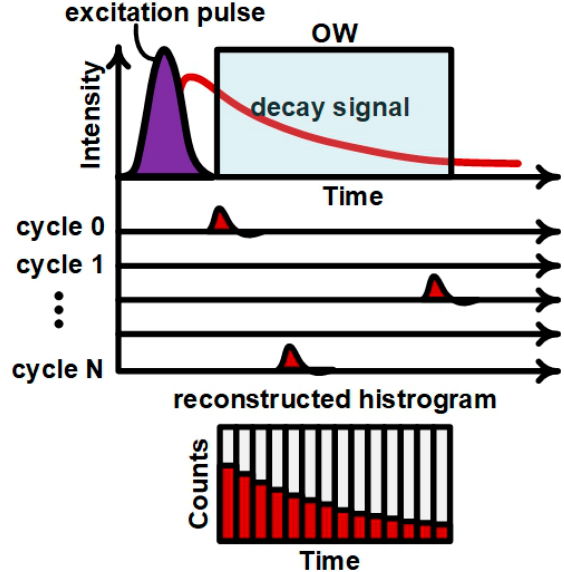
Figure 2. Measurement procedure applying the time gating to cut off the laser.